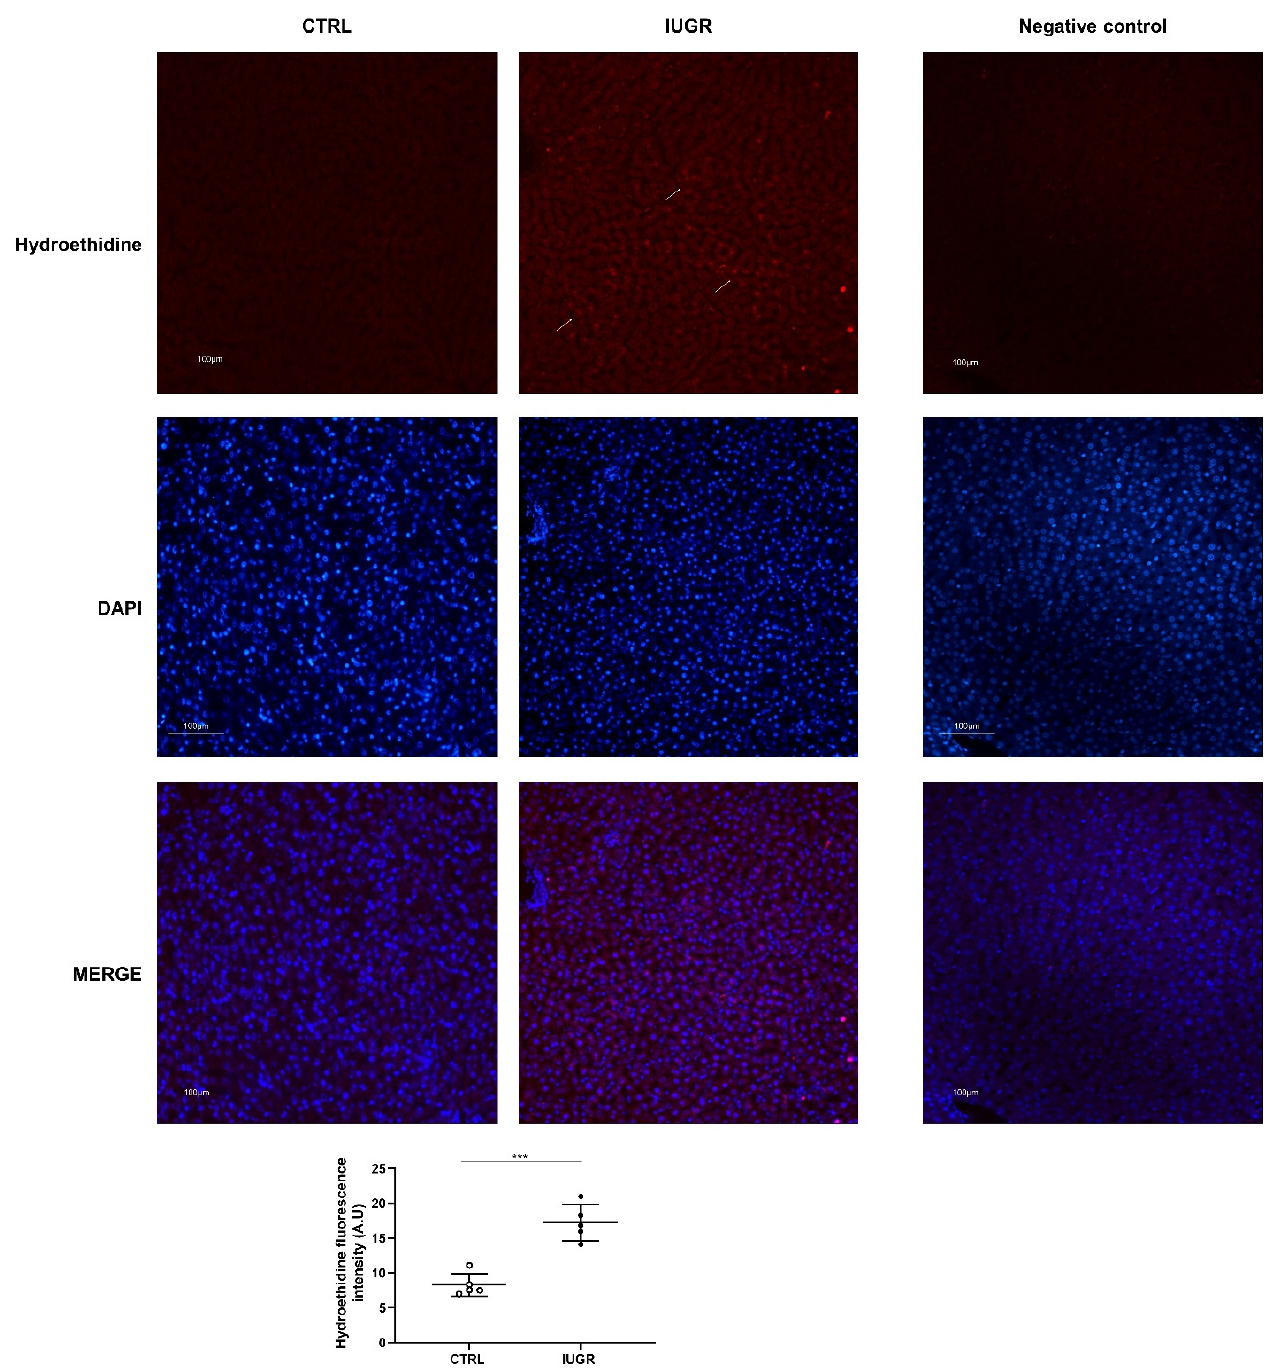
Figure 7. Superoxide anion production in the liver from CTRL and IUGR males at 6 months of age. The superoxide anion production (arrows) was evaluated using hydroethidine staining in CTRL and IUGR males. A negative control was established. Nuclei were counterstained with DAPI. n = 5 animals/group. *** p < 0.001. Magnification (20×). Scale bar = 100 µm.